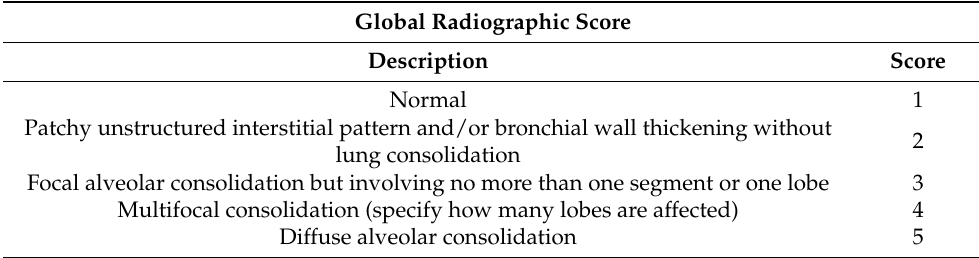
Table 1. Global radiographic score (GRS) according to a severity scoring system used for the assessment of pneumonia in children and adapted from Taylor et al. [15]. Lung consolidation is defined herein as an area of increased radiographic opacity of the lung in which the vessels are indistinct with or without air bronchograms or lobar margination. Global Radiographic Score Description Score Normal 1 Patchy unstructured interstitial pattern and/or bronchial wall thickening without 2 lung consolidation Focal alveolar consolidation but involving no more than one segment or one lobe 3 Multifocal consolidation (specify how many lobes are affected) 4 Diffuse alveolar consolidation 5